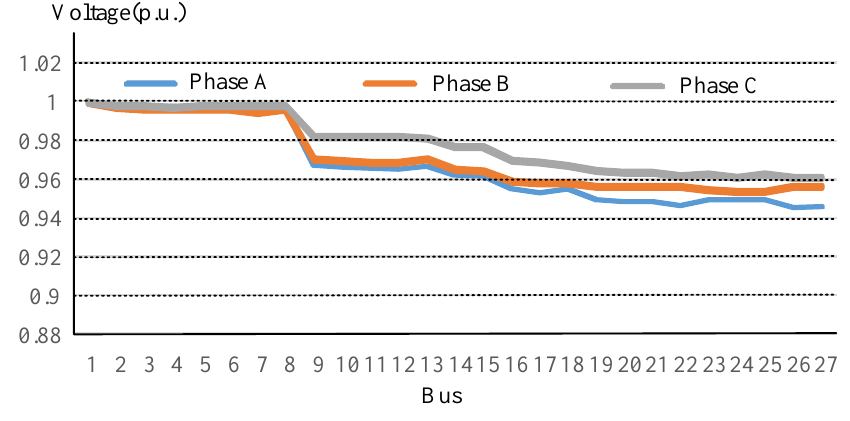
Figure 6. The three-phase voltage profiles of each bus before the phase rearrangement at the heavy load period.